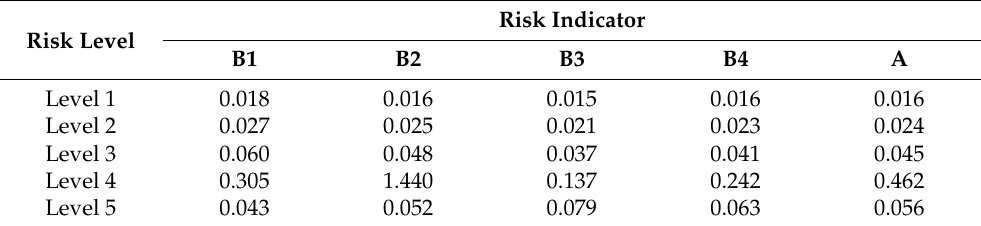
Table 6. Proximity calculation